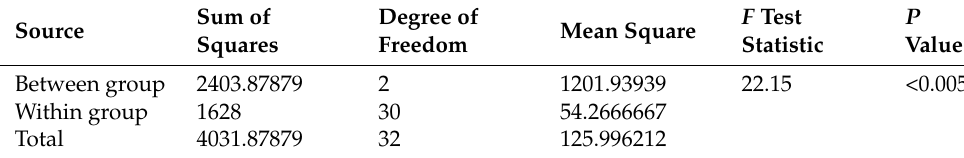
Table 2. Analysis of variance based on the serial numbers of eye